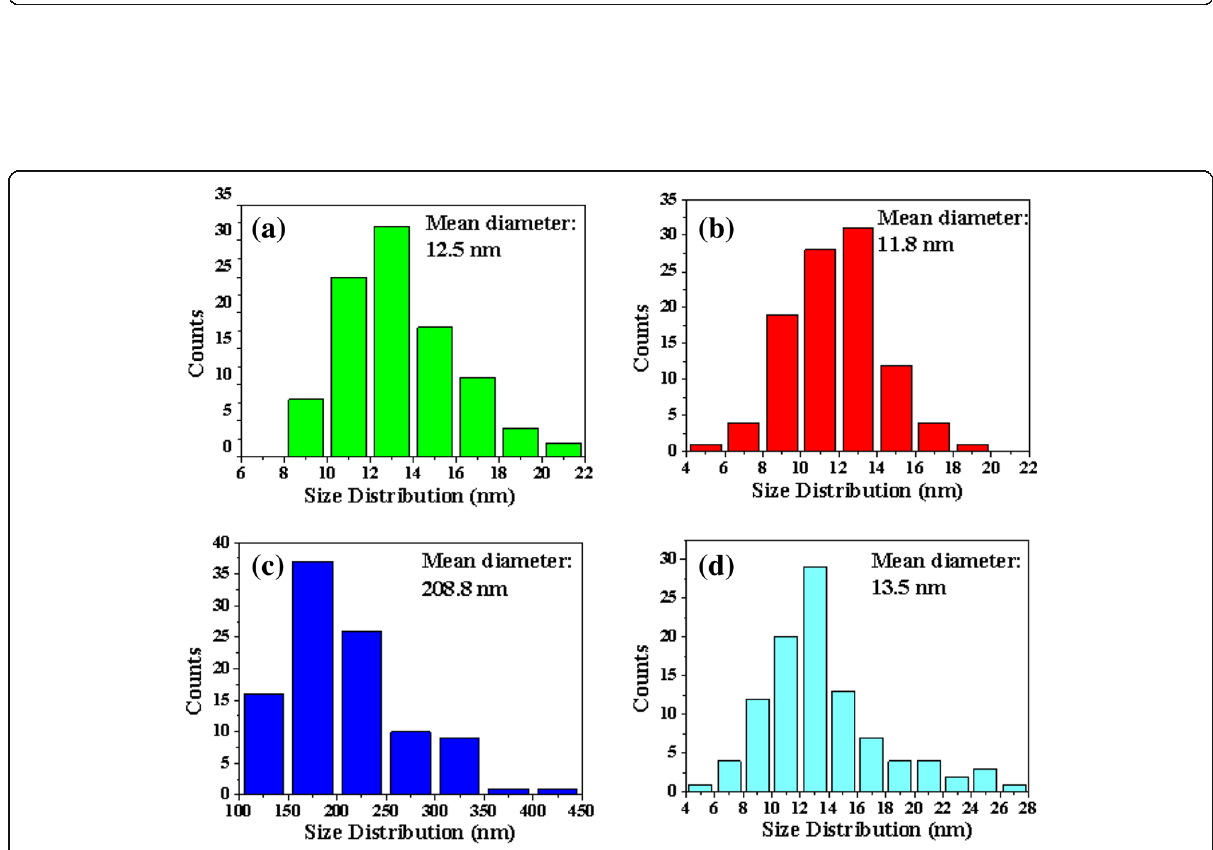
Fig. 5 Size distribution of catalyst nanoparticles measured from the FESEM data by manual analysis of 100 particles on different buffer layers: